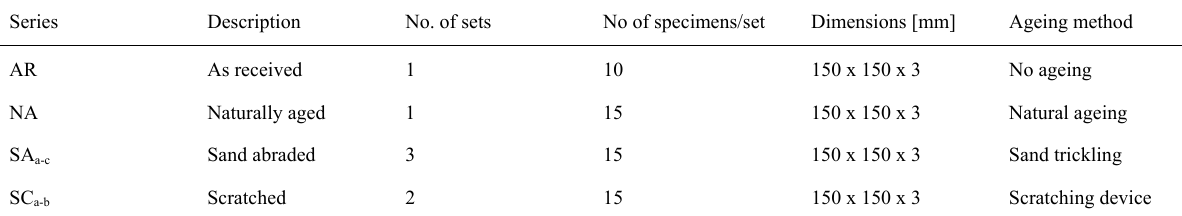
Table 1: Series overview.